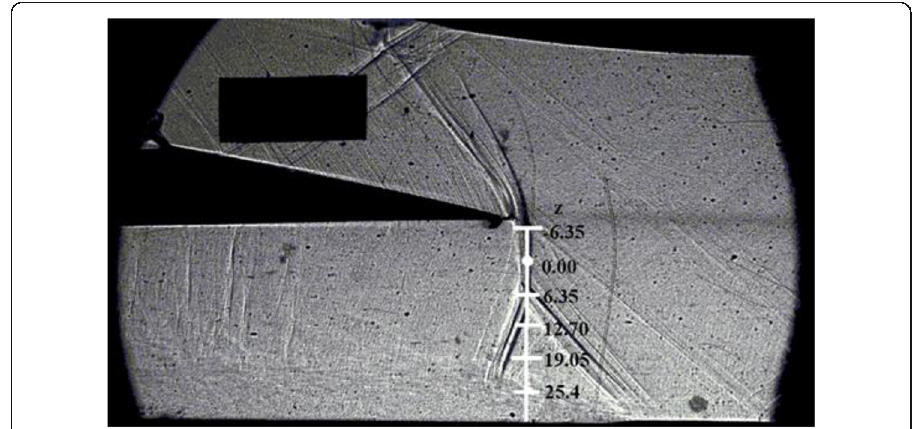
Fig. 19 Shadowgraph flow visualization image, where white dot and white line show locations where magnitude squared coherence and time lag are determined and analyzed at a frequency of 40 Hz to